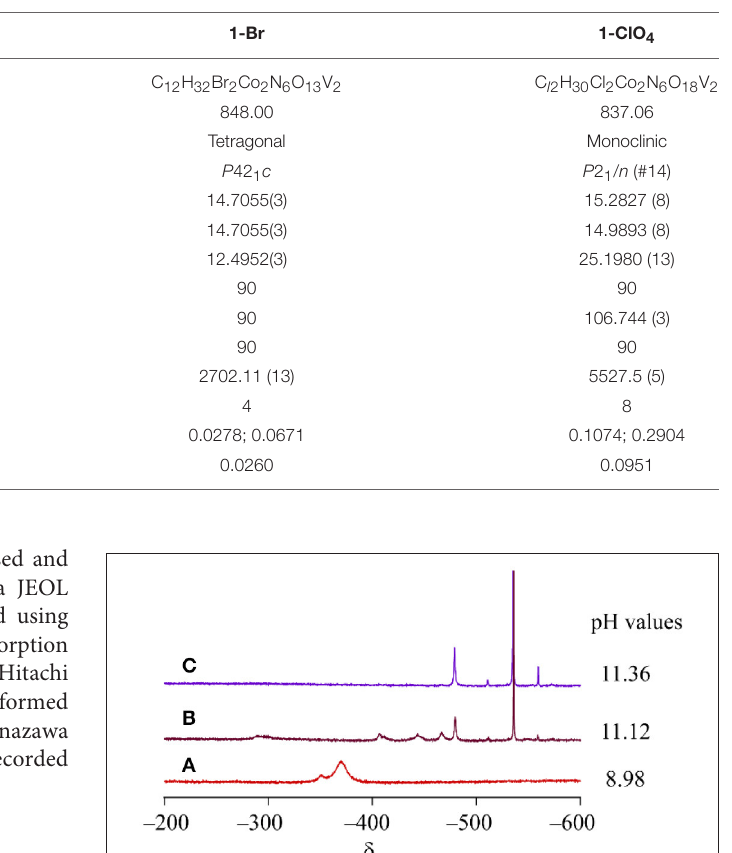
TABLE 1 | Crystallographic data for 1-Cl , 1-Br , and 1-ClO 4 .